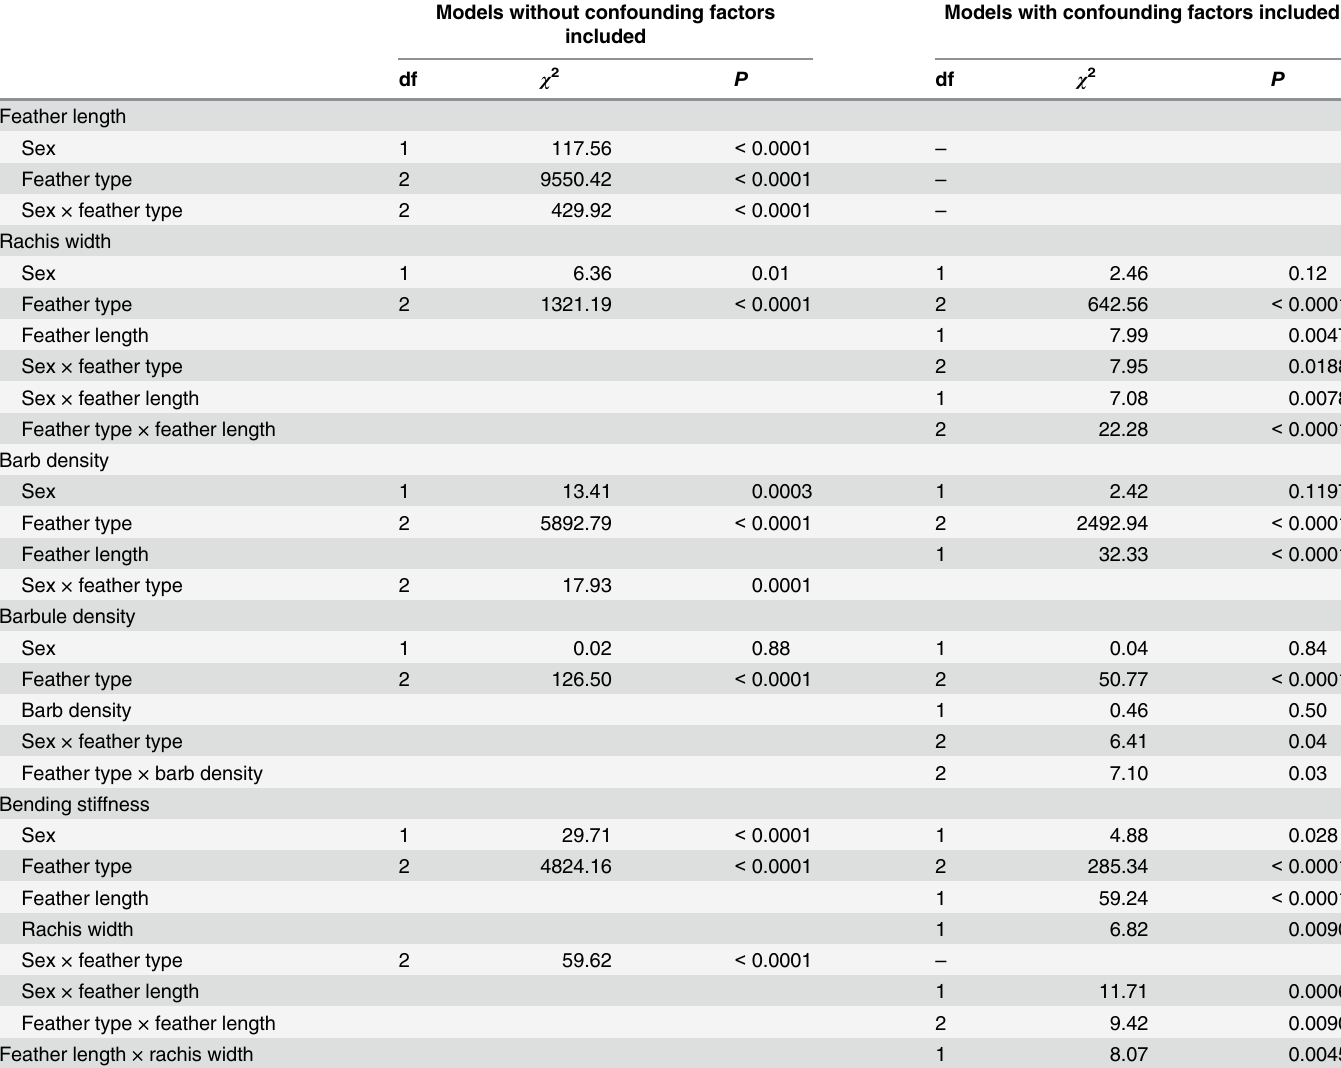
Table 1. Linear mixed-effects models of variation in feather structure of wing (P1) and tail feathers (Ta5 and Ta6) between sexes of barn swallows from the Romanian